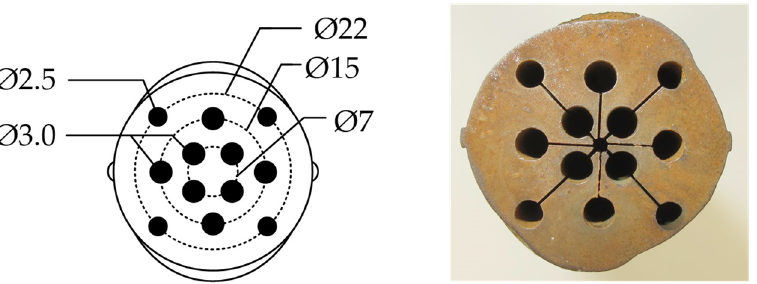
Figure 3. Specimen distribution over the cross-section containing the different depths and diameters of the cylindrical microstructure specimens ( left ), and cross-section of the whole rebar after eroding the microstructure specimens ( right ). Table 2. Test matrix of the experimental program.